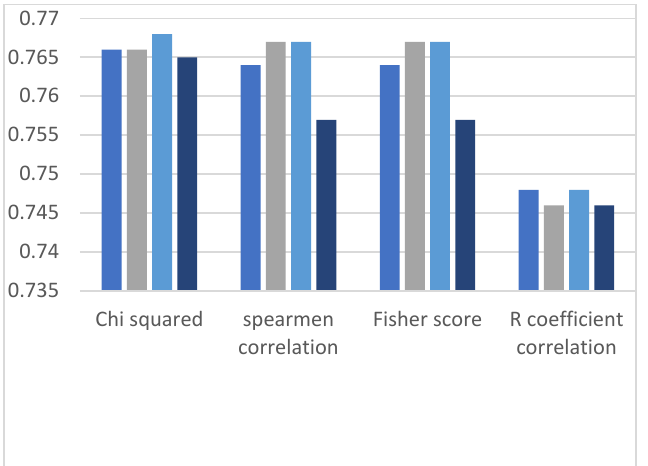
Figure 5. Accuracy using enhanced NN.